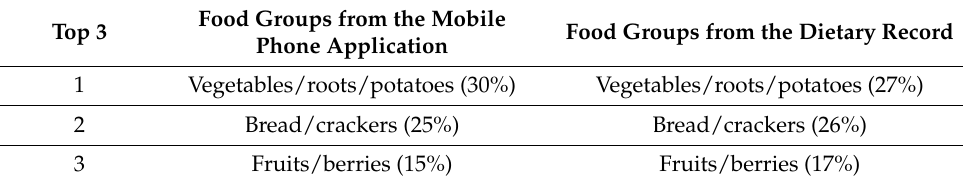
Table 4. The three food groups that contributed the most to total dietary fiber intake from registrations in the mobile phone application and the dietary records ( n = 26).